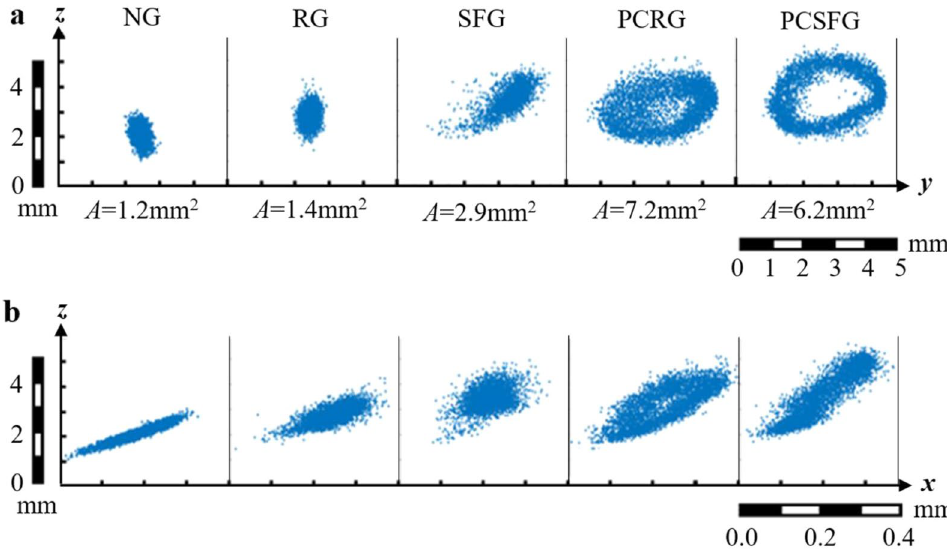
Figure 6. Trajectory of SPTV tracer particle in the ( a ) cross-sectional and ( b ) side view induced from various grid